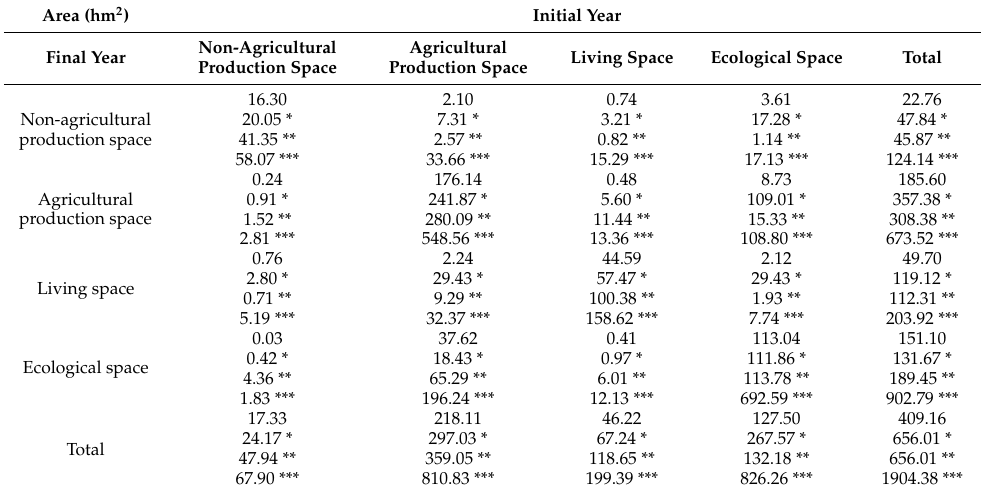
Table 2. Spatial transfer of EPL spaces from 1990 to